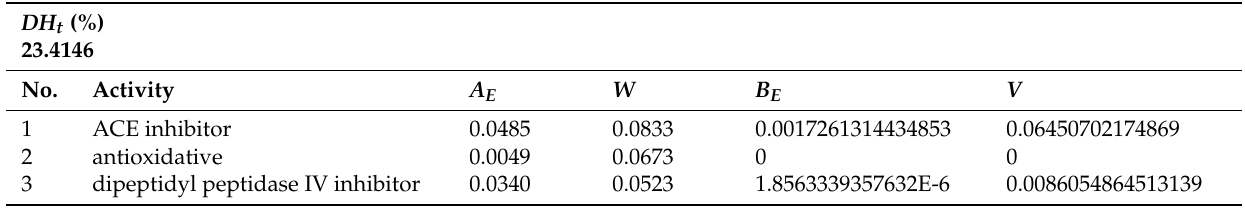
Table A2. A E , DH t , W , B E and V values from RubisCO of Halophila stipulacea . In silico enzymatic cleavage carried out by using chymotripsin.